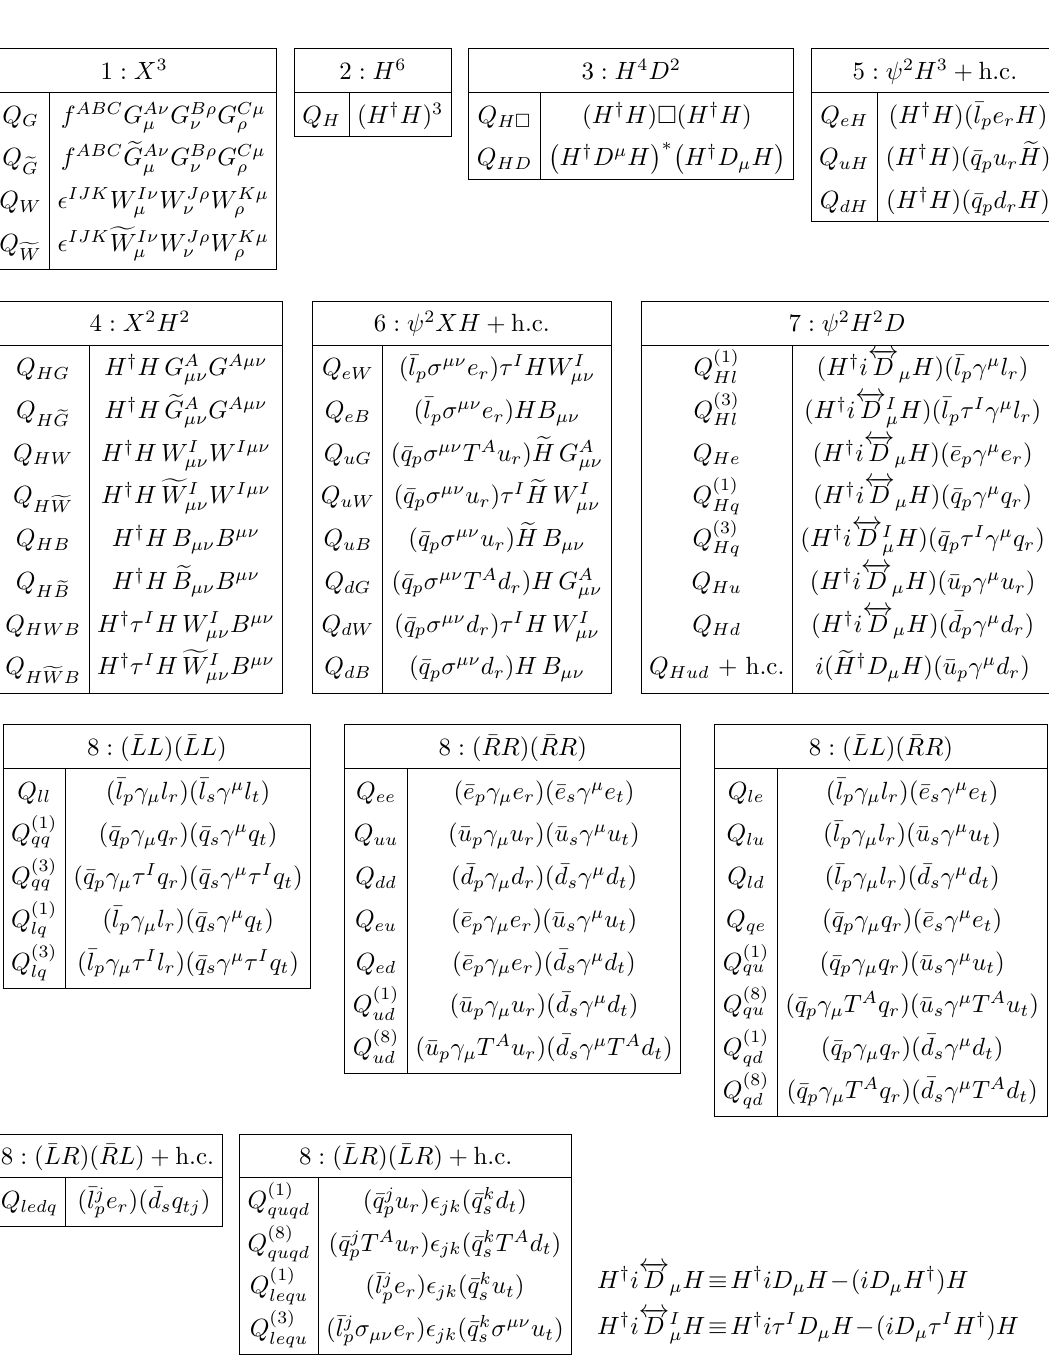
Q (8) ((cid:22) u p (cid:13) (cid:22) T A u r )( (cid:22) d s (cid:13) (cid:22) T A d t ) ud